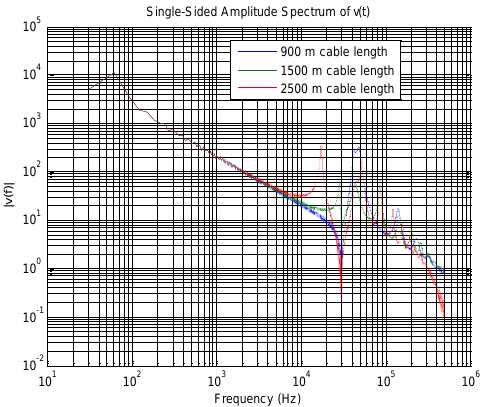
Fig. 8. FFT analysis for phase-c secondary voltage for different lengths.